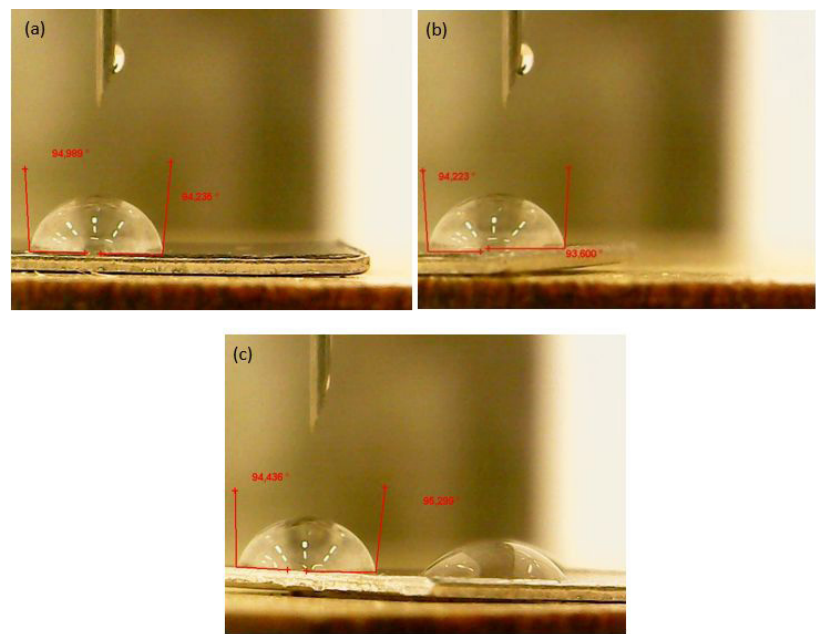
Figure 9. Wettability of the “as received” sample. (a) Drop 1, (b) Drop 2 and (c) Drop 3.